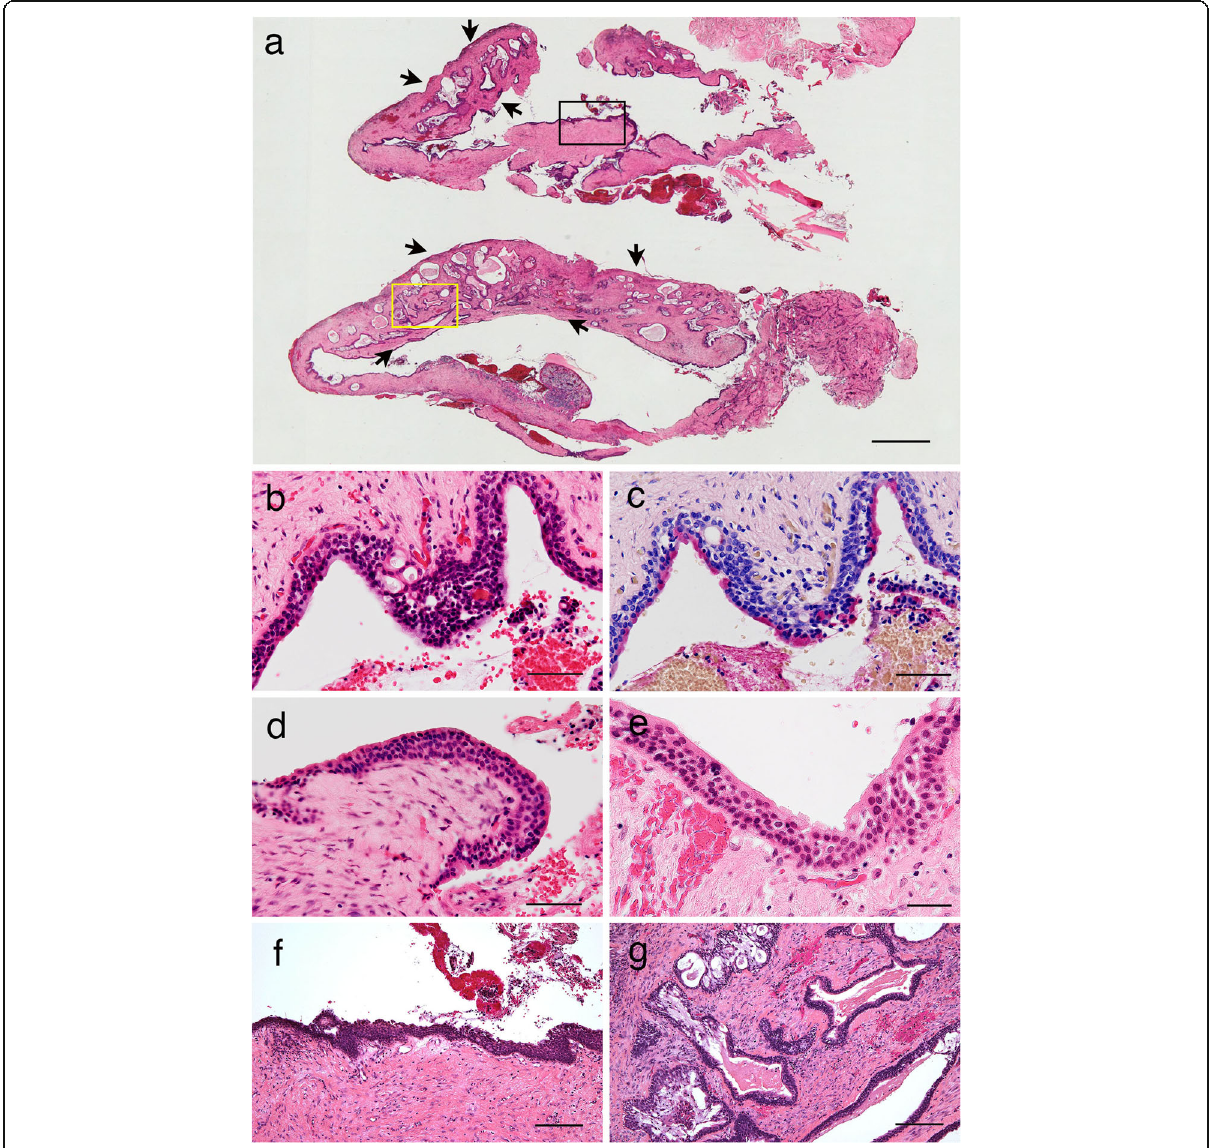
Fig. 2 Histopathology of central MEC arising from a GOC of the mandible in a biopsy specimen. a The biopsy showed an enlarged unilocular cyst with thick fibrous connective tissue, along with a polycystic lesion on one side (black arrows). b Numerous microcysts and mucous goblet cells were observed in the cyst lining epithelium. c Mucous goblet cells were positive for mucicarmine staining. d Eosinophilic cuboidal cells were seen within the lining epithelium. e Ciliated cells were scattered within the non-keratinized squamous epithelial cells. f The cyst wall consisted of fibrous connective tissue and non-keratinizing squamous epithelium in the GOC part (black square in a ). g Several cystic nests, which contained eosinophilic materials, were also found in the central MEC parts (yellow square in a ). Hematoxylin-eosin ( a – b, d – g) , mucicarmine stain ( c ), Scale bars, 1 mm ( a ), 20 μ m ( b – e ), 100 μ m ( f – g